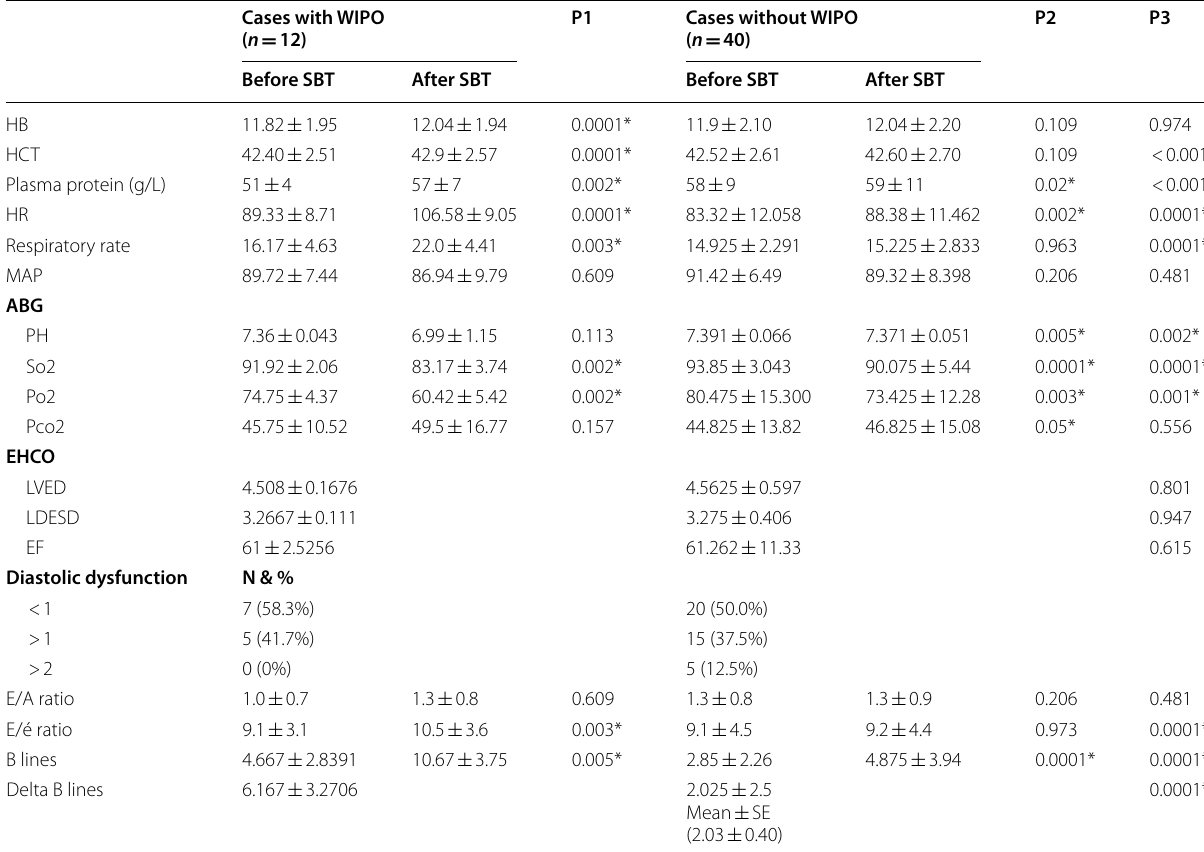
Table 2 Evaluation of variables during the SBT in patients with and without weaning‑induced pulmonary